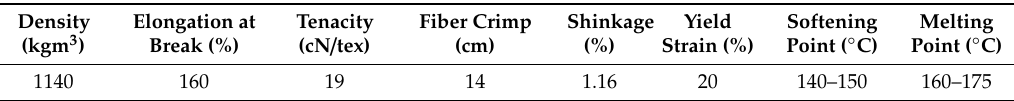
Table 1. The mechanical properties of the PP fibers (PA6-RM-14-030-supported by Lanxess energizing Chemistry Co., Ltd., Cologne, Germany).